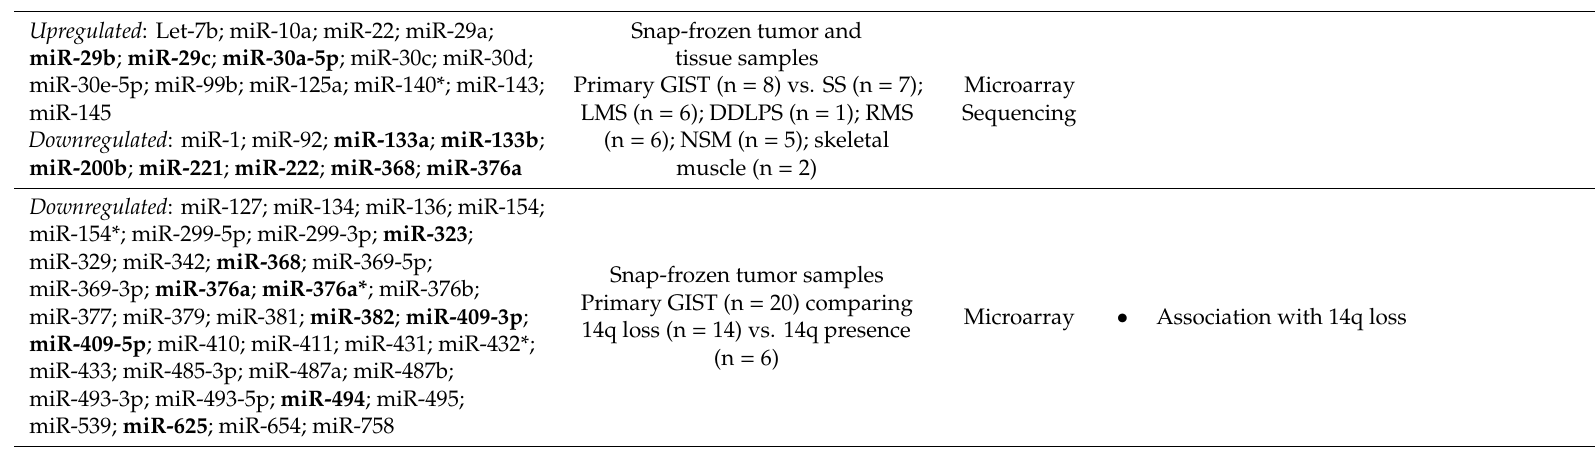
miRNAs Up / Downregulated in GIST